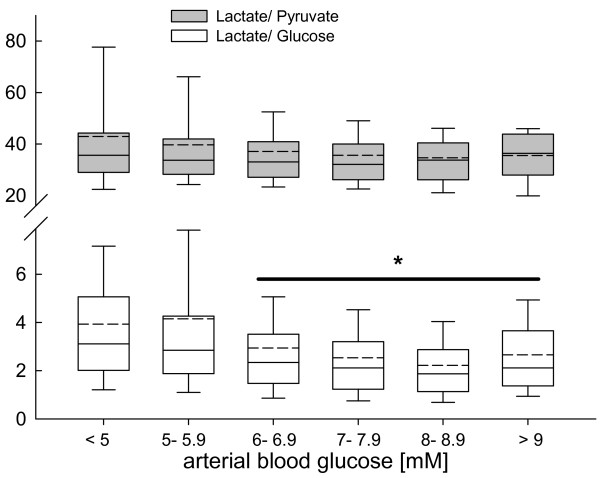
Changes in calculated brain lactate-to-pyruvate (grey box plots) and lactate-to-glucose (white box plots) ratio determined by microdialysis reflecting influence of blood glucose on downstream cerebral metabolism in pre- defined arterial blood glucose clusters, ranging from less than 5 mM to more than 9 mM in 1 mM buckets. At arterial blood glucose levels exceeding 6 mM brain lactate-to-glucose ratio was significantly decreased. Decreases across the pre-defined blood glucose clusters compared with low arterial blood glucose levels were significant (*P < 0.001; analysis of variance on ranks, post hoc Dunn's test).